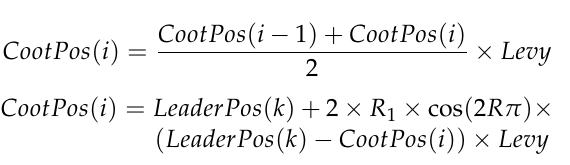
Figure 3. Relationship between arbitrary real numbers and their opposition-based learning num- bers.